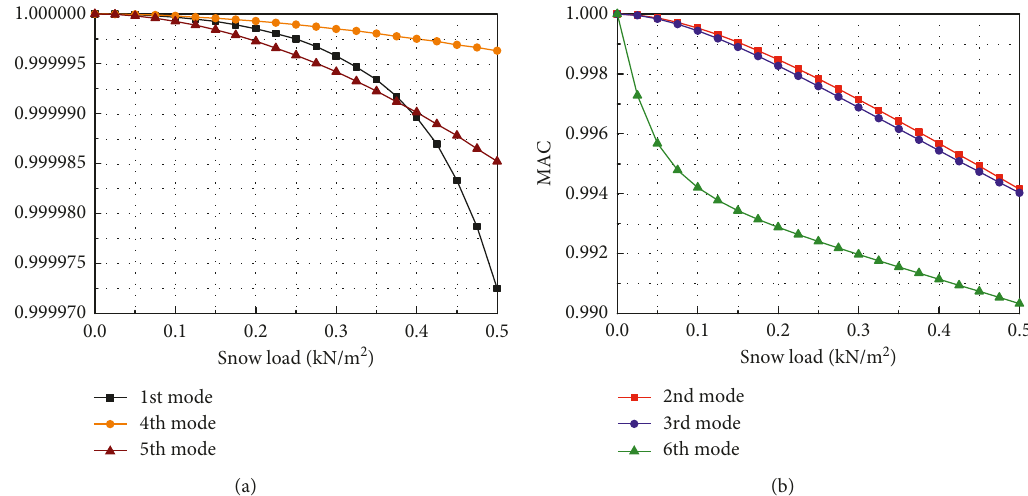
Figure 30: MAC values of the mode shapes on vertical direction under nonuniformly distributed snow load: (a) the 1st, 4th, and 5th modes and (b) the 2nd, 3rd, and 6th